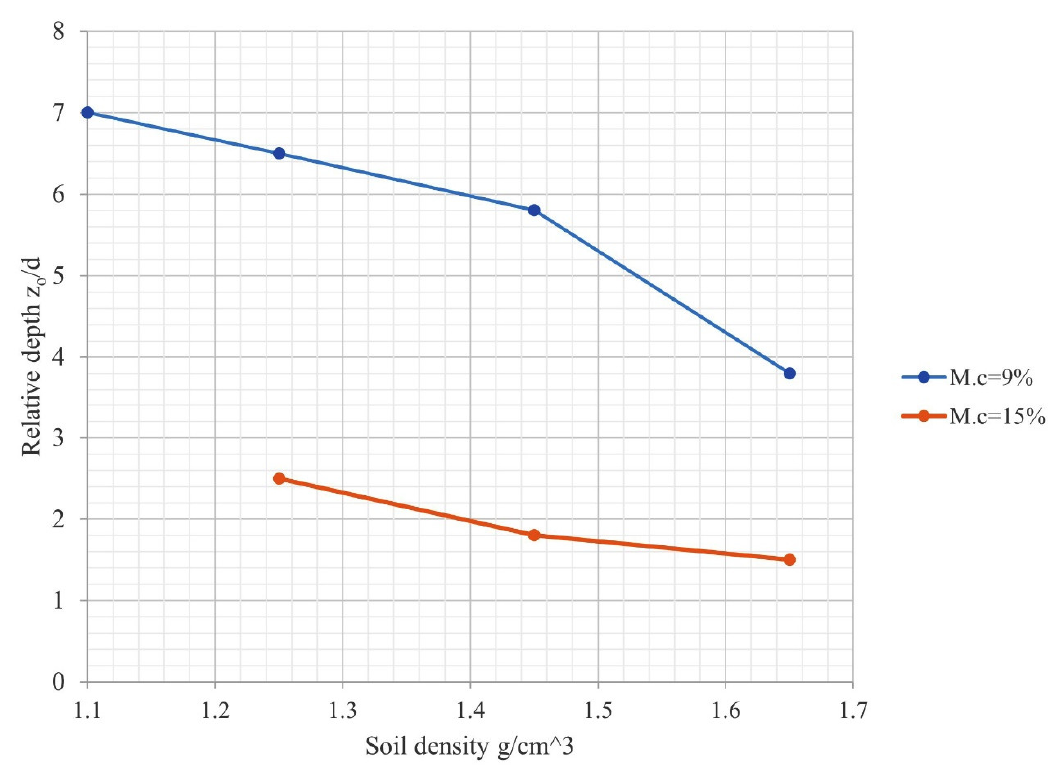
Figure 3. Relative depth (z o /d), with soil density at a moisture content level of 9% and 15% for a penetrometer cone of 1.6 cm in diameter.